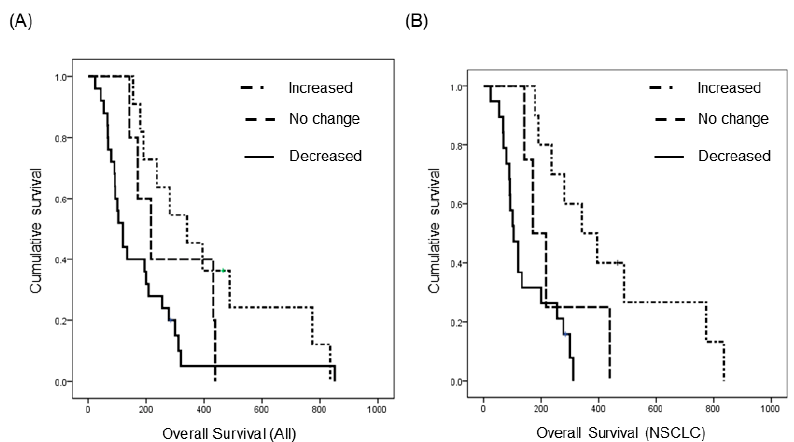
Figure 3. Kaplan–Meier overall survival analysis of patients who received the same intra-CSF chemotherapy for LM according to the extracellular vesicle concentration change after the treatment. ( A ) All 41 patients with various primary cancer ( p < 0.05), and ( B ) non-small cell lung cancer patients (n = 33, p < 0.001).